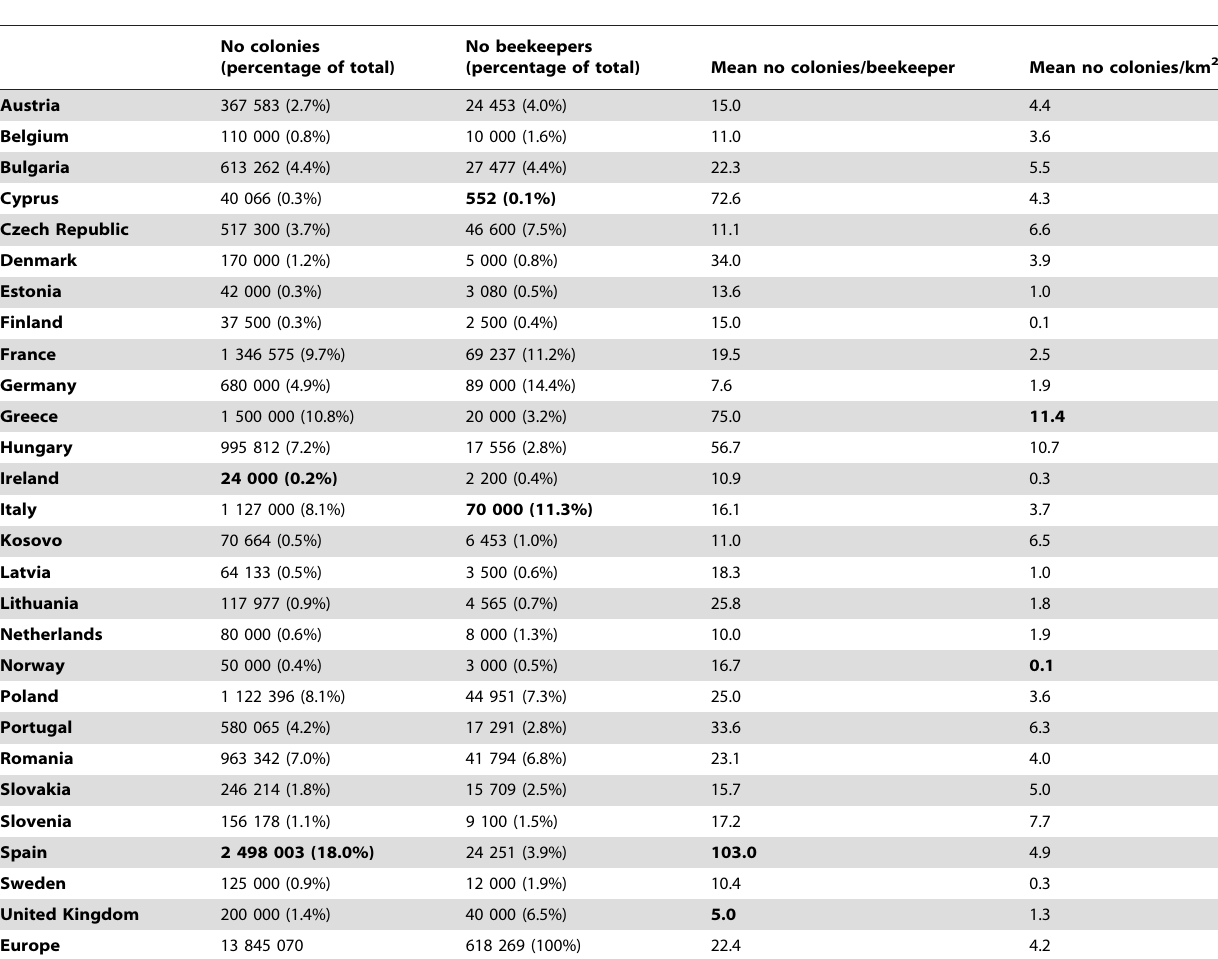
Table 1. Livestock (honeybee colonies), number of beekeepers, distribution and density of honeybee colonies in the European Union in